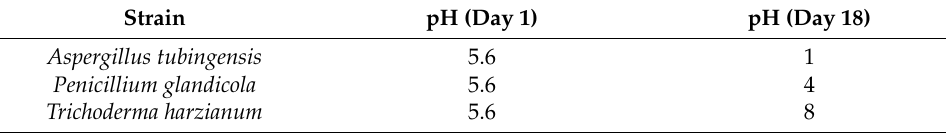
Table 4. pH at the beginning and at the end of the growth dish